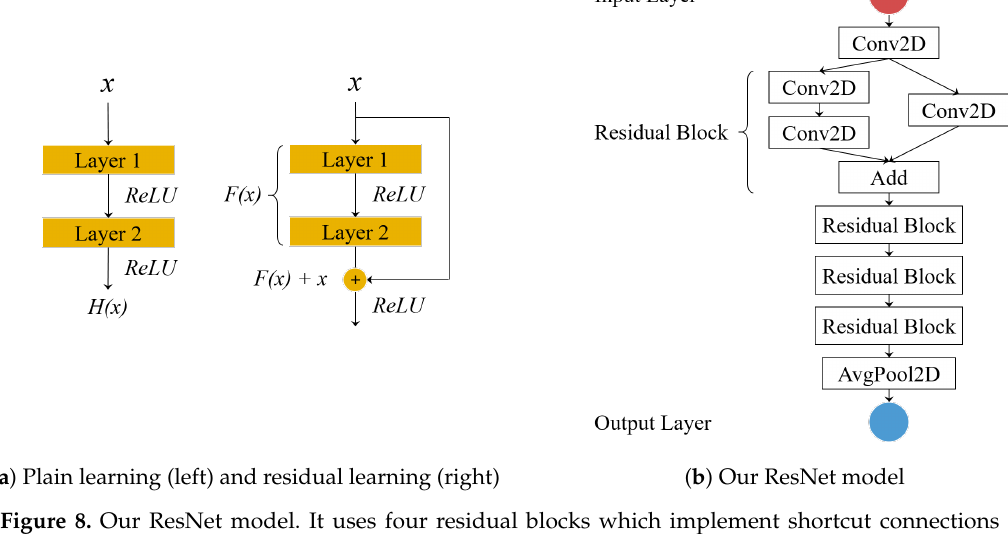
Figure 8. Our ResNet model. It uses four residual blocks which implement shortcut connections between two convolution